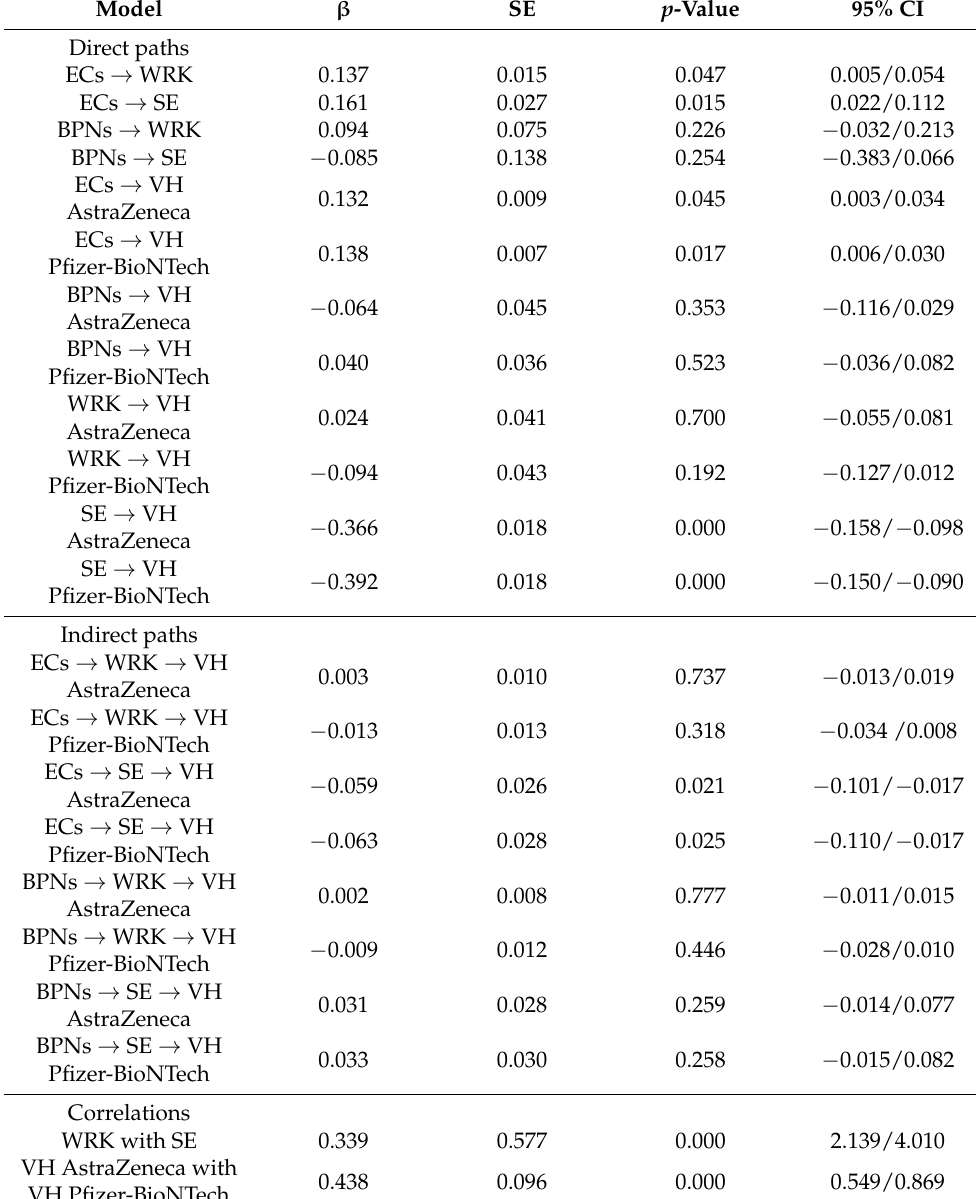
Table 2. Parameter estimates from the structural equation modeling for existential concerns, basic psychological needs, attitudes toward COVID-19 vaccines and vaccine